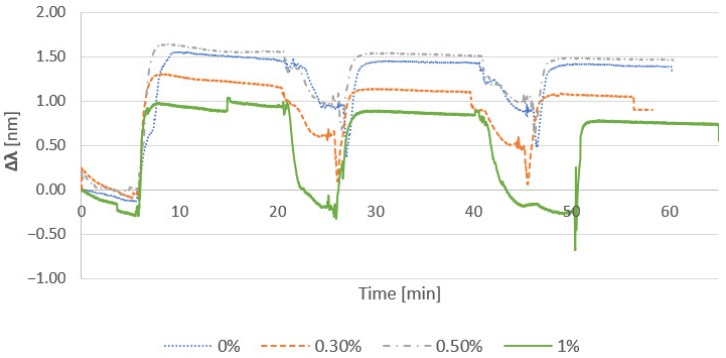
Figure 6. NPS signal as a function of time for samples formulated with APG/CAPB 12 wt. %, cationic polymer 0.5 wt. %, and different levels of salt at room temperature and pH ~7.